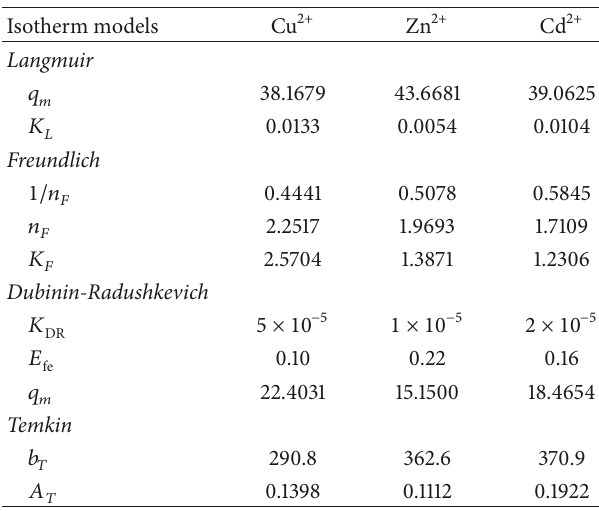
Table 2: Isotherm parameters for sorption of heavy metal ions by the zirconium-based ferromagnetic